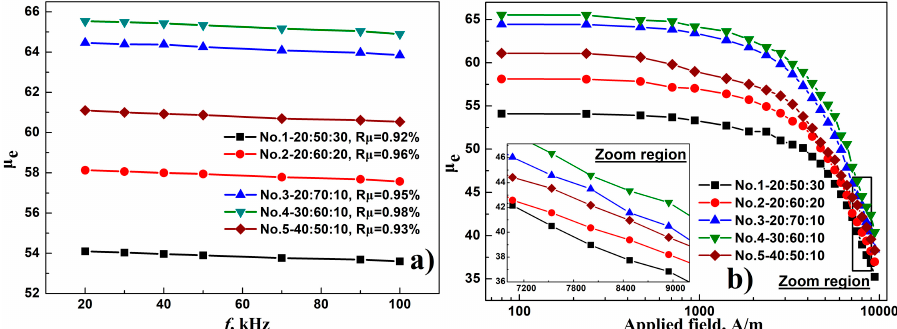
Figure 3. Dependence of matching ratio on frequency characteristic ( a ) and direct current (DC) bias performance ( b ).